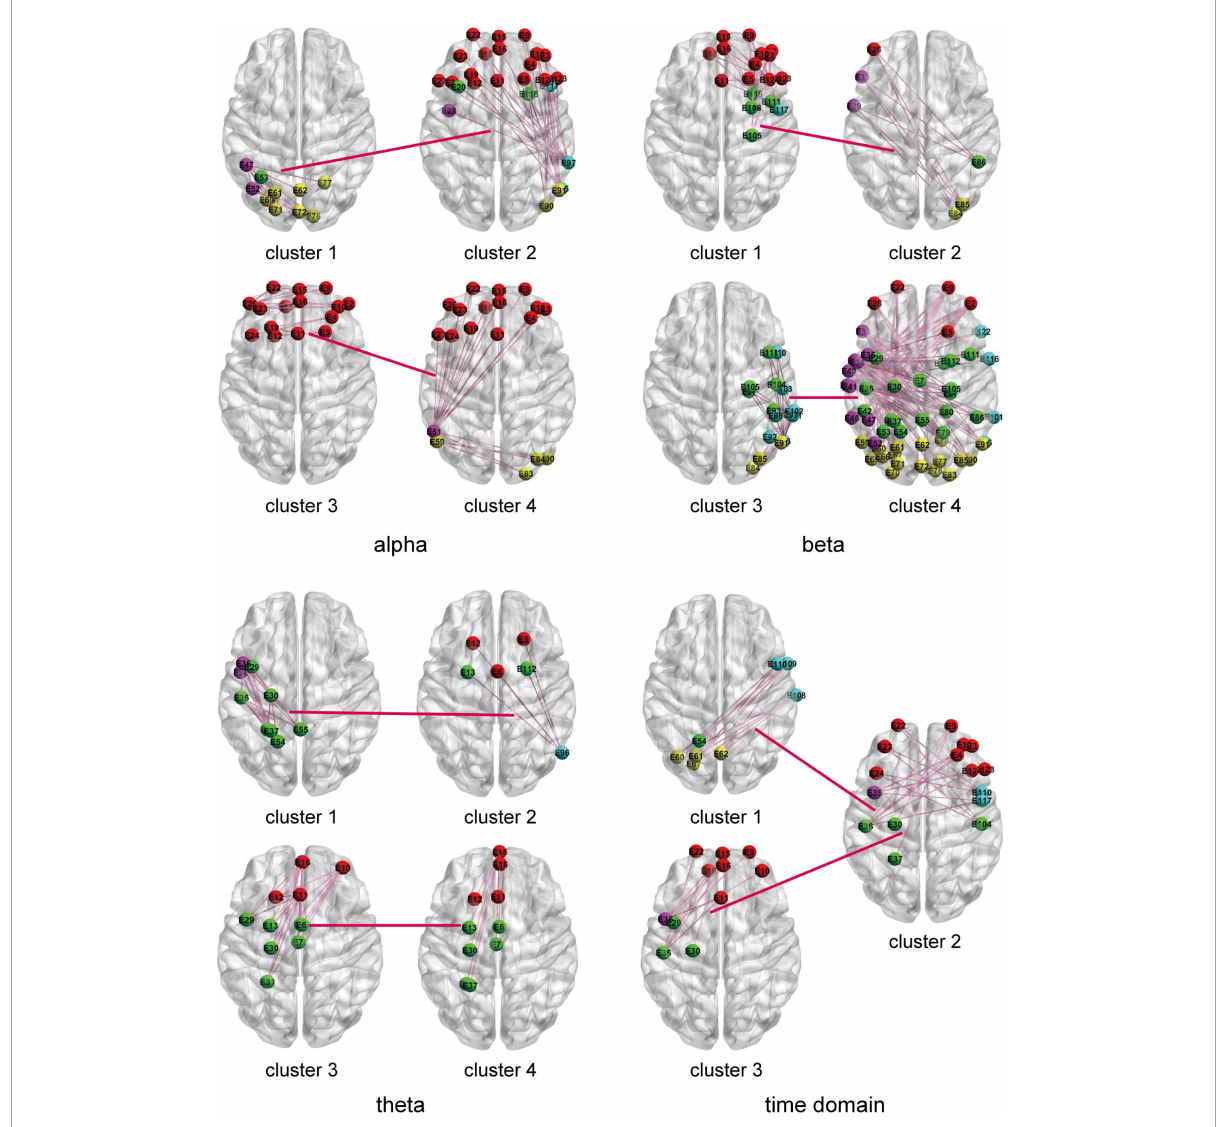
FIGURE6 The two most frequently selected connection diagrams for different HO-BFNs. Each brain diagram represents the FC of interest channels across the brain region in a cluster.